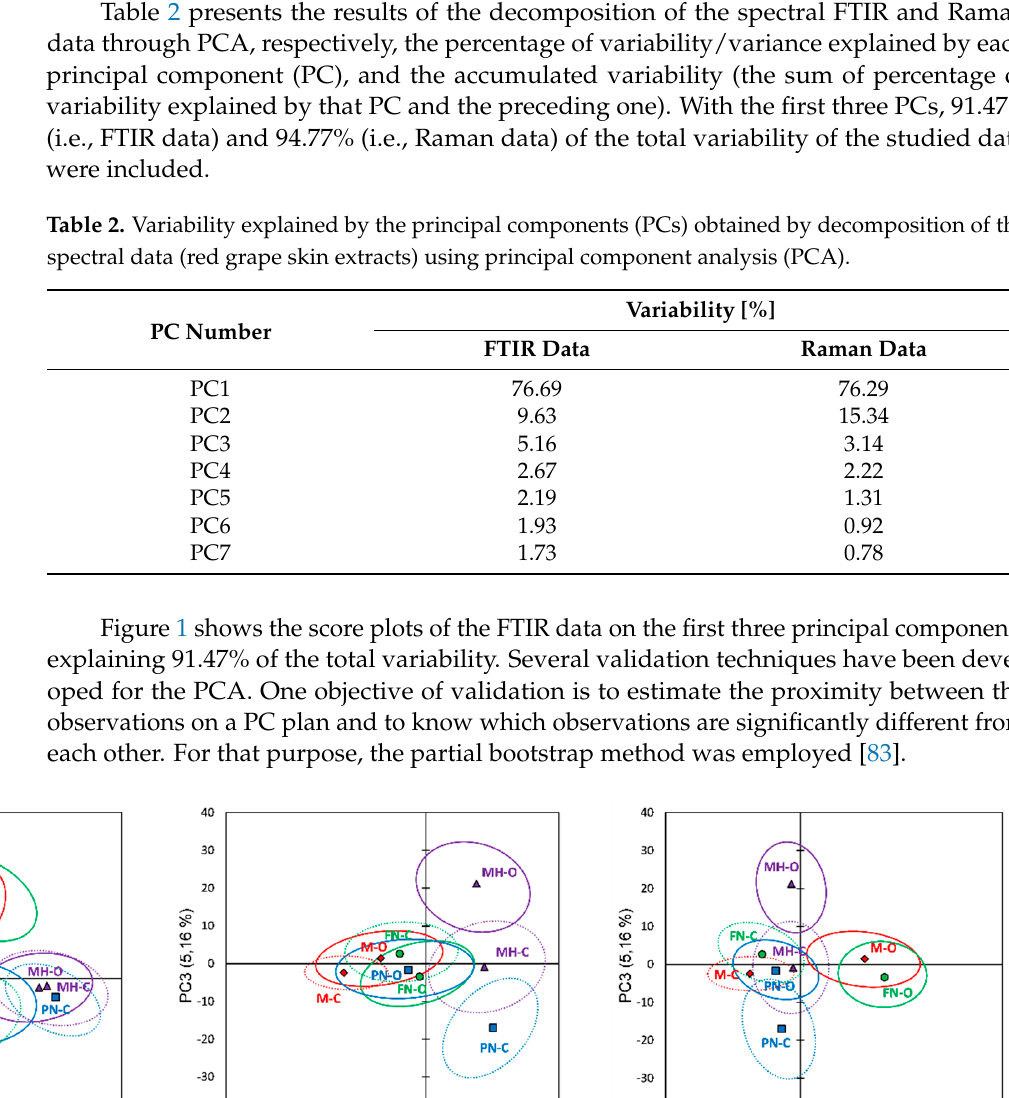
Table 2. Variability explained by the principal components (PCs) obtained by decomposition of the spectral data (red grape skin extracts) using principal component analysis (PCA).